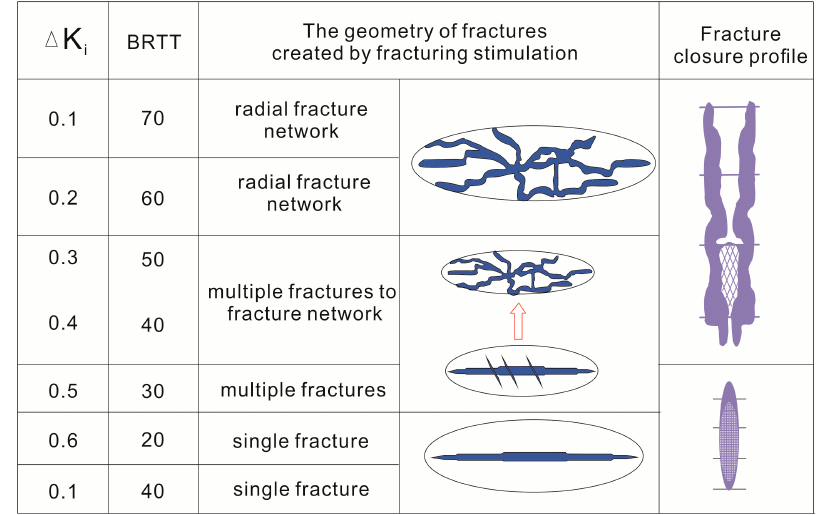
Figure 8. The diagram for the fracture forming conditions for the stimulation of a gas reservoir [37,44].